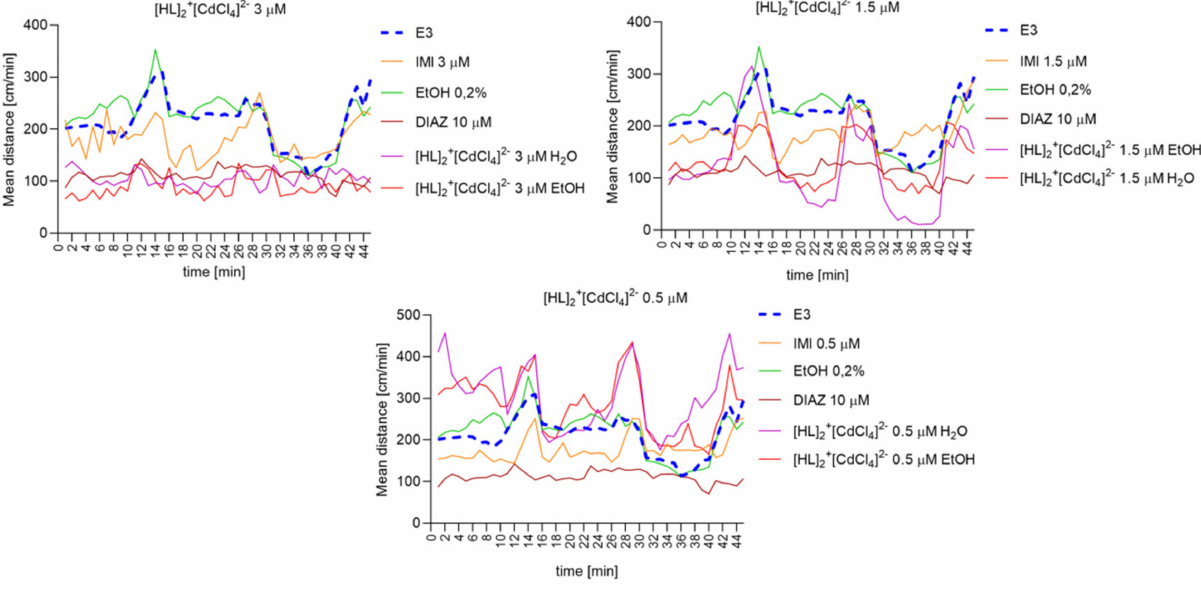
Figure 14. The changes detected during 45 min of the locomotor activity test (three 15- minutes light–dark sessions: 0–10-min of illumination followed by 11–15 min of darkness, 16–25 min of illumination followed by 26–30 min of darkness, and 31–40 min of illumination followed by 41–45 min of darkness) after 40 min of continuous illumination) under the influence of different concentrations of [HL] 2 + [CdCl 4 ] 2 − in the solvent-dependent and light–dark-dependent manner of